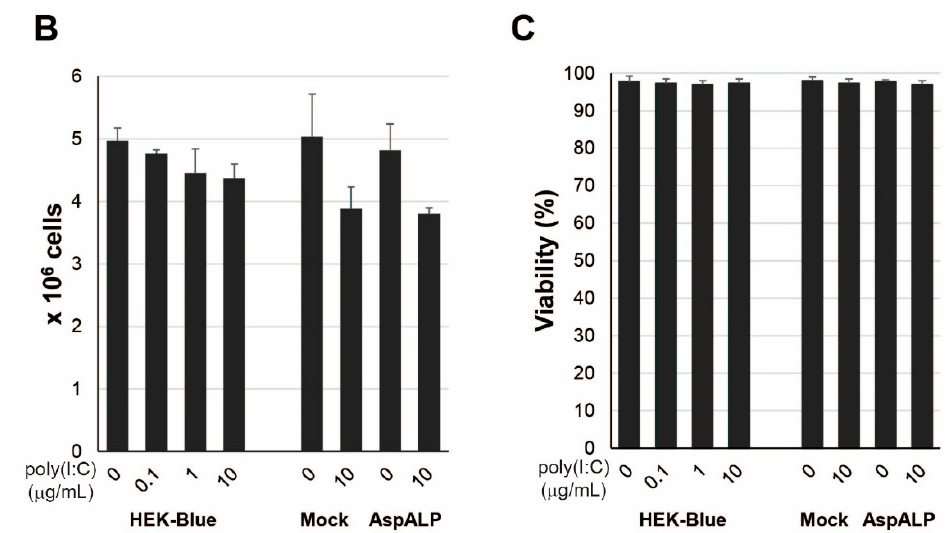
Figure 3. Morphology and growth in cells stimulated with poly(I:C). ( A ) Morphology of T-REx Mock (Mock), T-REx AspALP (AspALP), and HEK-Blue hTLR3 (HEK-Blue) cells after three days in the presence or absence of poly(I:C) at 10 μ g/mL. Scale bar indicates 50 μ m. The number ( B ) and viability ( C ) of cells after three days in the presence or absence of poly(I:C) at 0–10 μ g/mL.